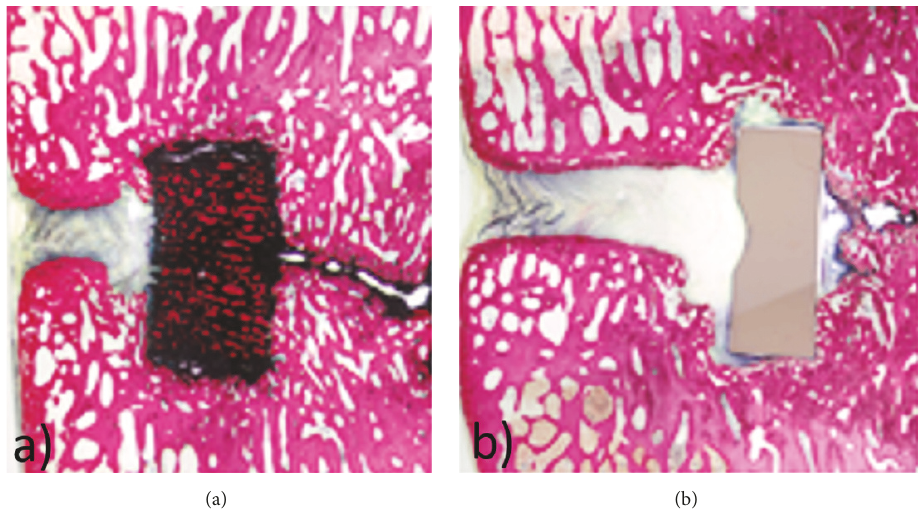
Figure 11: 4-month histological analysis of (a) porous Nitinol and (b) PEEK device. Bone growth throughout the pores of porous Nitinol and fibrous tissue encapsulation around solid PEEK.